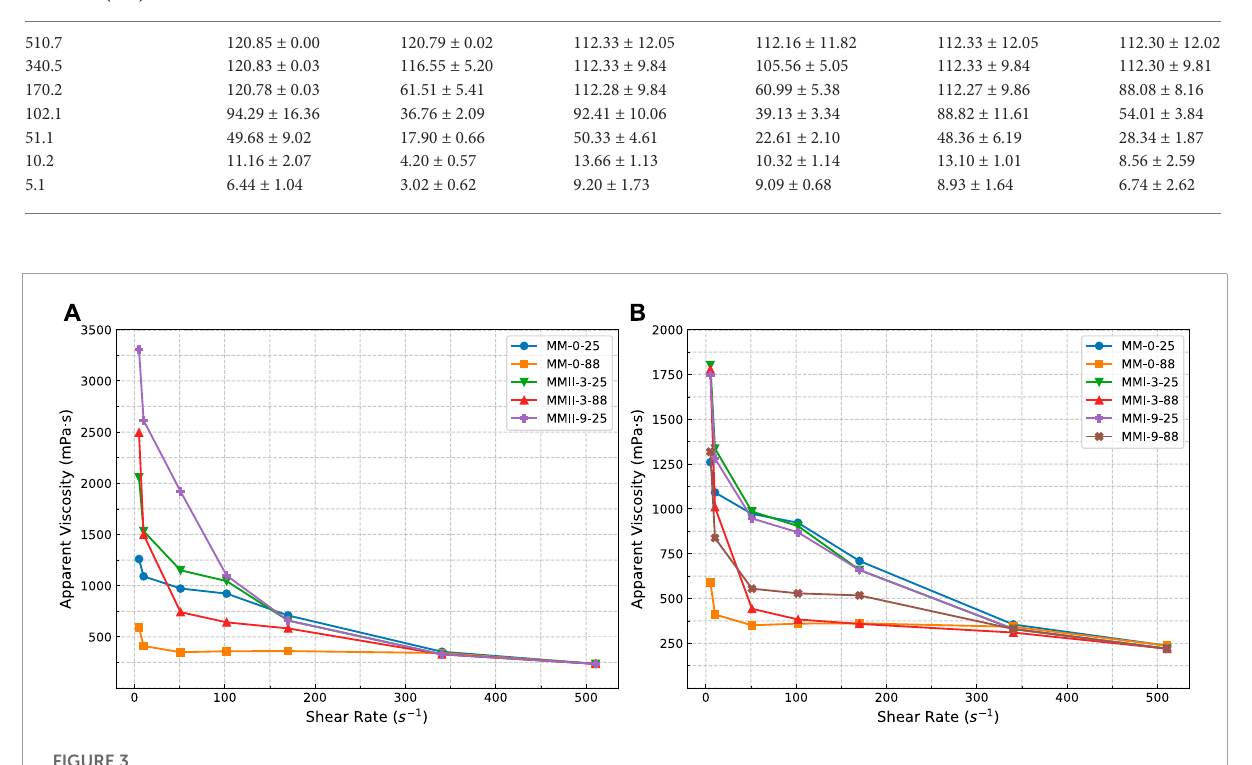
FIGURE 3 Apparent viscosity versus shear rate of slurry samples. (A) On slurry samples incorporated with MMII; (B) on slurry samples incorporated with MMI; MMI refers to type I micro-sized magnesium oxide; MMII refers to type II micro-sized magnesium oxide; MM refers to micro-sized magnesium